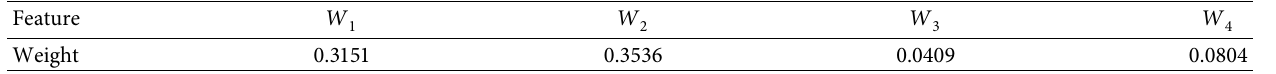
Table 3: The weight of single feature.